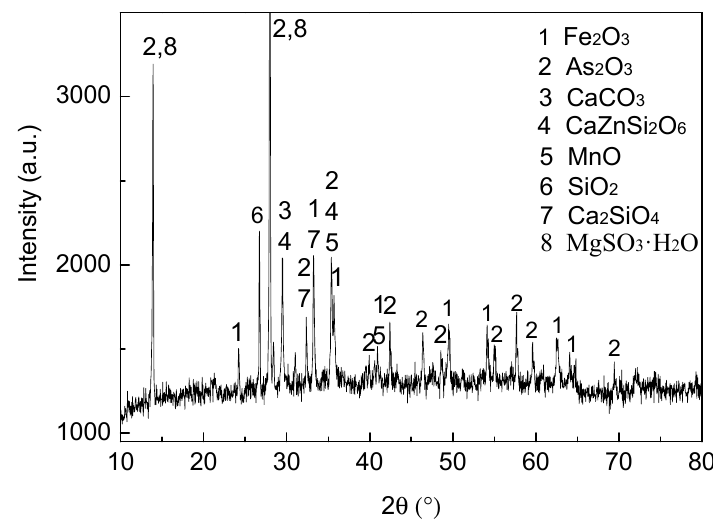
Figure 2. XRD spectra of the mixed dust ash powder.